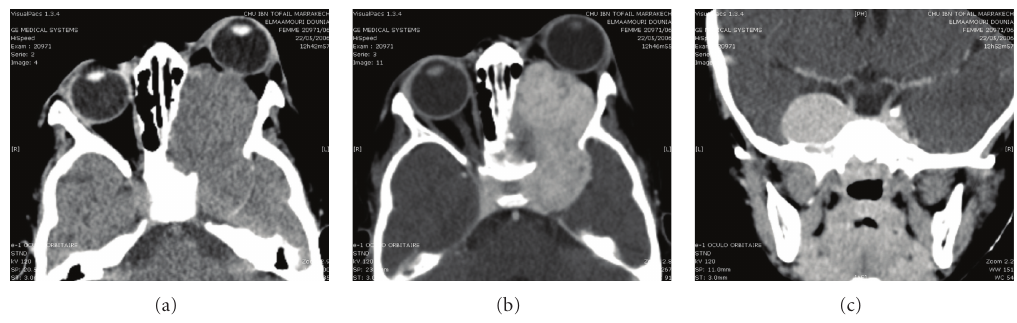
Figure 2: CT scan on axial (a) and coronal (b) views with contrast administration shows an endoorbital tumor involving the optical nerve spreading to the cavernous sinus and widening the pterygopalatine